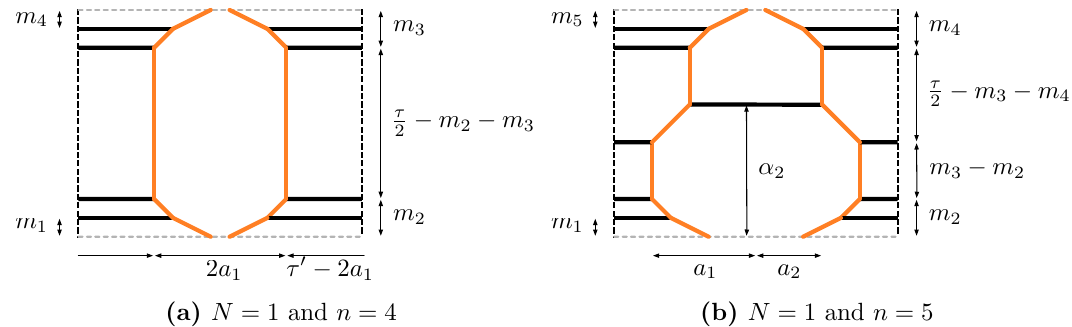
Figure 6. K(cid:127)ahler parameters in the generic 5-brane con(cid:12)gurations at N = 1 and n = 4 ; 5 where the superscripts A/B distinguish respectively the LSTs studied in section 2 and